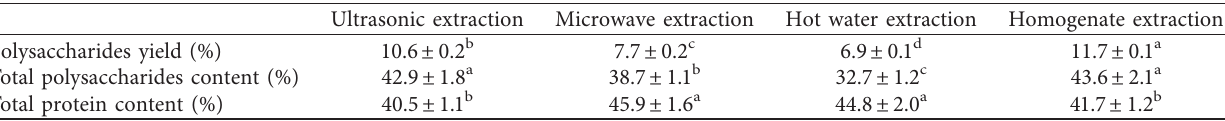
Table 3: The polysaccharides yield, total polysaccharides, and protein contents of the PNMP extract produced by three convention methods and optimized homogenate extraction